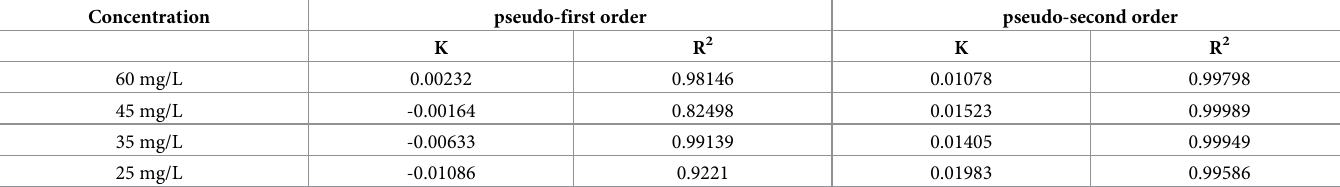
Table 2. Parameters of the process of orange II by GO/MOFs.